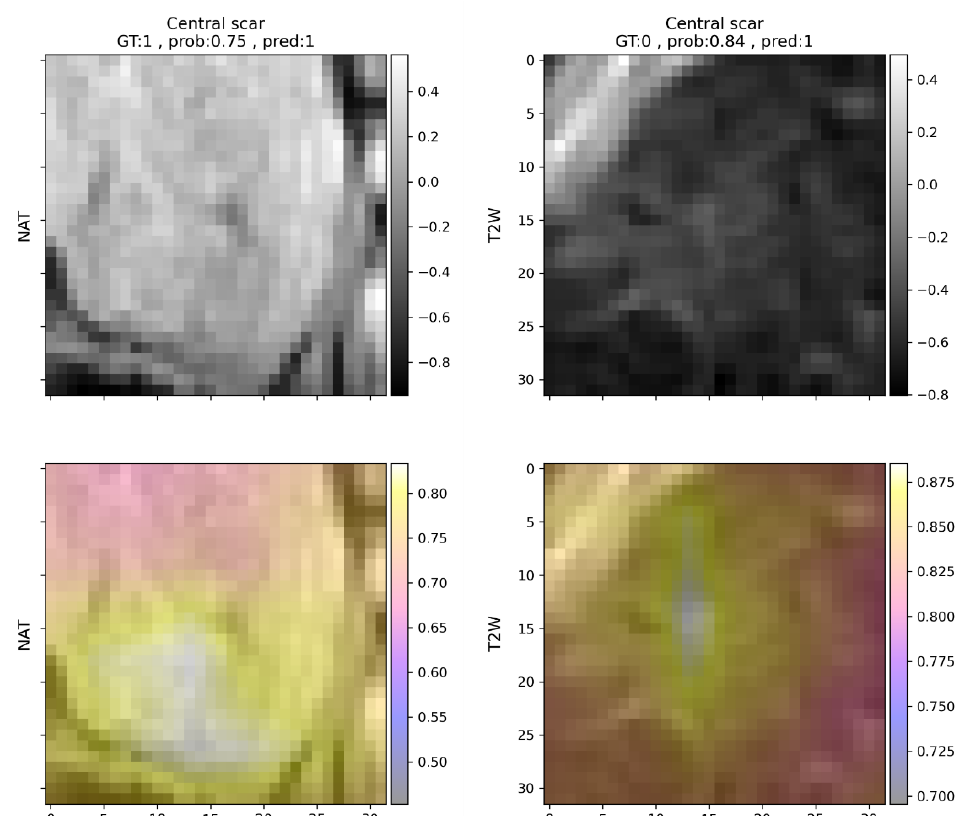
Figure 3. Two examples (in each column) of central scar predictions in focal nodular hyperplasias. Left: correct prediction, right: incorrect prediction. Upper row: native T1-weighted ( left ) and T2- weighted ( right ) images. Rescaled voxel intensities are indicated on the y -axis. Lower row: occlusion sensitivity maps indicating the contribution of each voxel to the prediction. In the case of the T2- weighted image, the area representing the central scar presumably increases the probability of the identification of this feature. In the case of the native T1-weighted image, the areas near the central scar led to the highest increase in the prediction probability. GT = ground truth, prob = probability, pred = prediction, NAT = native T1-weighted image, T2W = T2-weighted image. Among all lesion types, HCC feature prediction yielded the least desirable results.